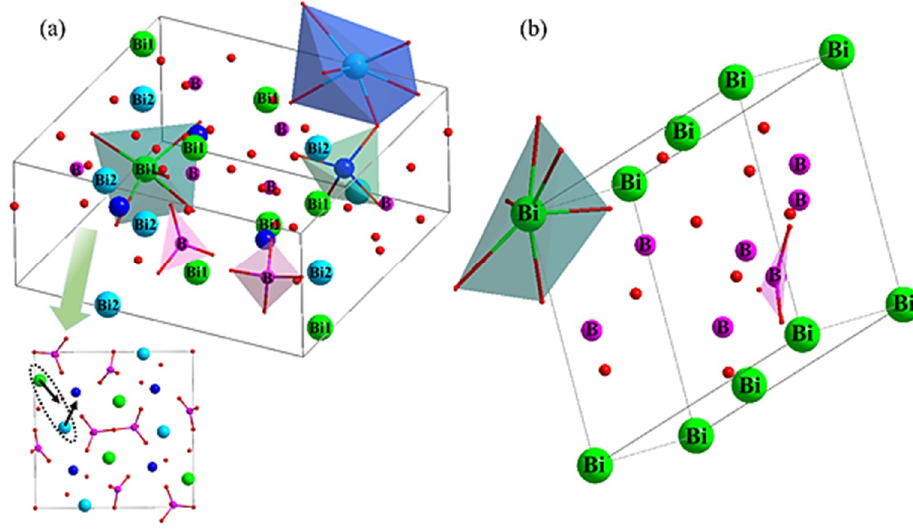
Figure 4. Crystal structures of BZBO ( a ) and α-BIBO ( b ) crystals.